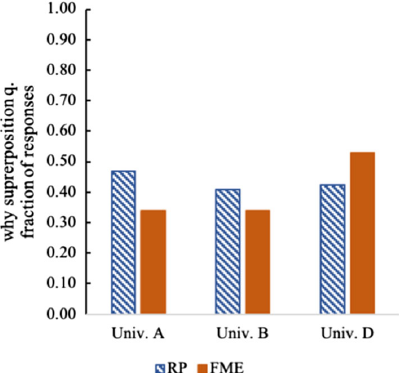
FIG. 13. Fraction of responses assigned the RP or FME codes for the predict-style question on superposition (the pulse sub- traction question).